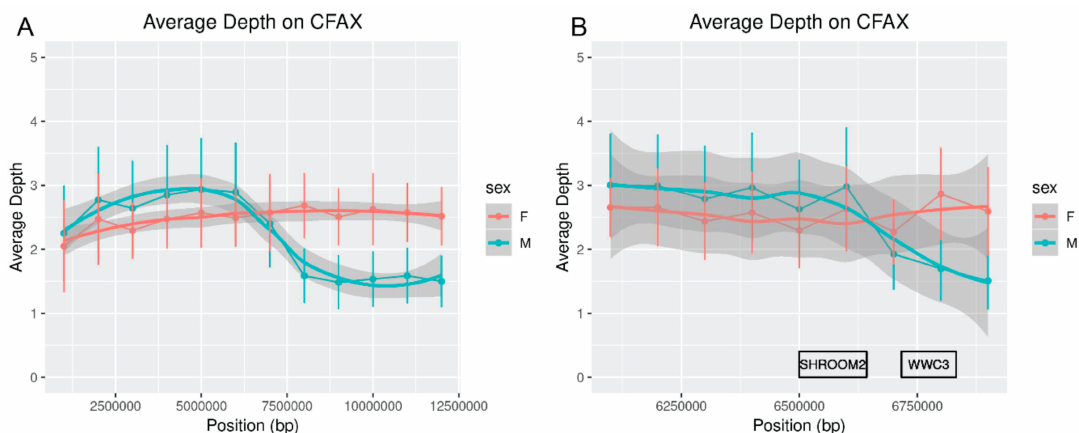
Figure 1. Average per-fox depth in males and females along dog chromosome X (CFAX). Bars represent the standard deviation of mean estimates, while the grey shading indicates the confidence interval based on smoothing with geom_smooth() in ggplot2 [51]. ( A ) Averages were calculated in 1-Mbp intervals. ( B ) Averages were calculated in 100-Kbp windows and are shown only for the region from chrX 6 Mbp to 7 Mbp. The two genes flanking the pseudoautosomal boundary on CFAX, SHROOM2 (pseudoautosomal) and WWC3 (X-chromosomal), are indicated as rectangles along the x